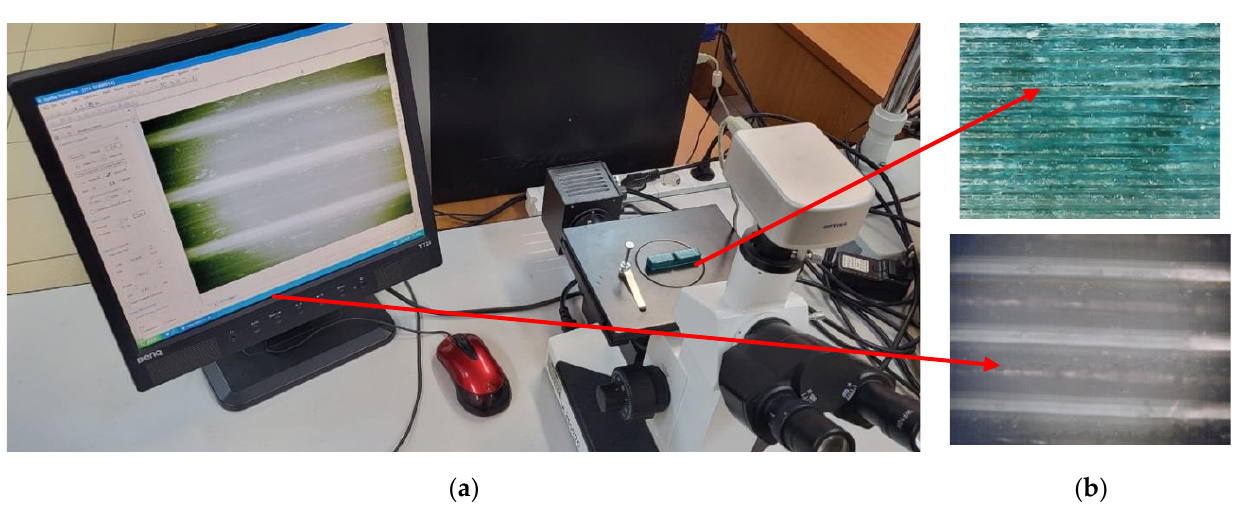
Figure 12. Surface analysis: ( a ) Optech microscope; ( b ) surface images.